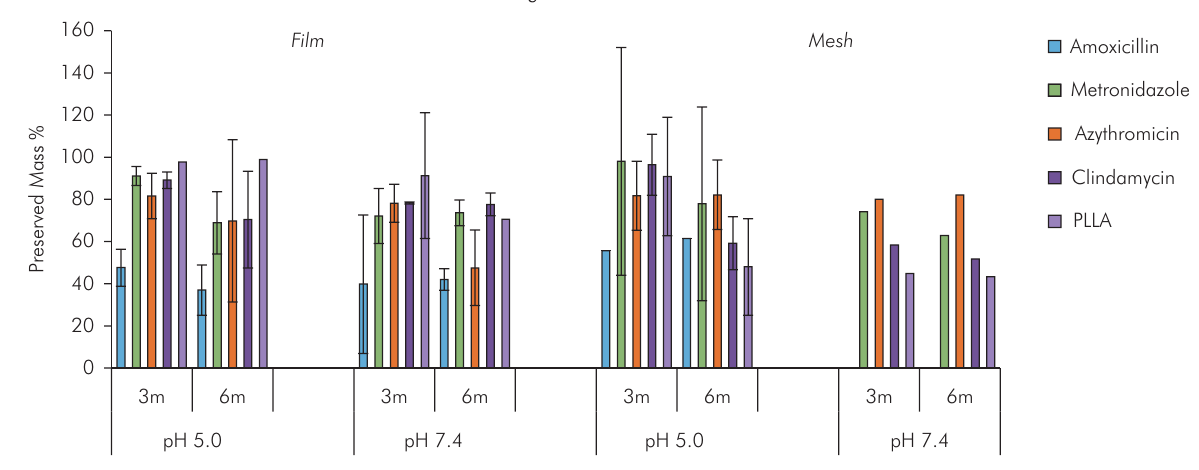
Figure 8. Degradation